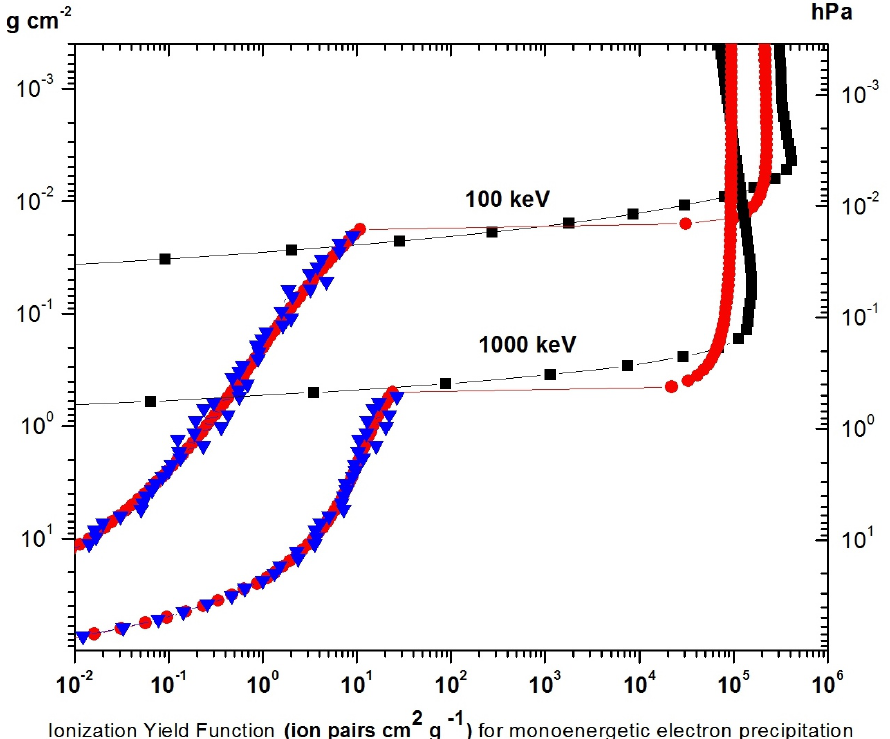
Figure 1. The yield function for isotropic monoenergetic precipitating electrons with energies 100 keV and 1000 keV. Blue triangles are ionization due to the Bremsstrahlung radiation computed by using the GEANT4. Red curves with circles are ionization presented in a look-up table in the Supplementary Materials. Black lines with squares—direct ionization yield functions were taken from Reference